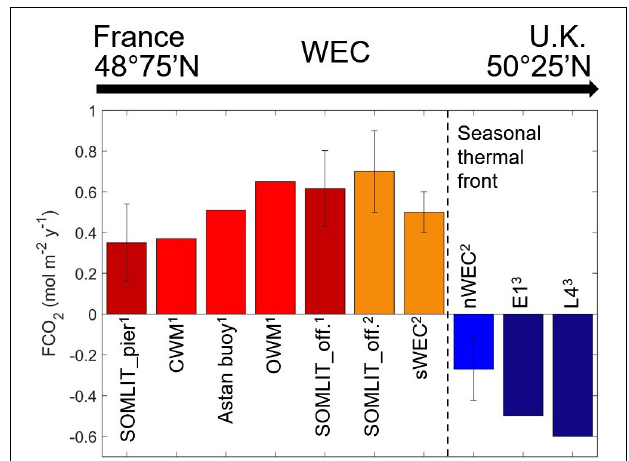
FIGURE 10 | Annual mean FCO 2 (mol C m − 2 y − 1 ) across the WEC at discrete stations SOMLIT-pier and SOMLIT-offshore for the 2015–2019 period (dark red), in the CMW, OMW and at ASTAN based on HF data from 2016 and 2019 (red) from this study 1 ; at SOMLIT-offshore (orange), in the sWEC (orange) and nWEC (blue) for the period 2011–2013 from Marrec (2014) 2 ; and at discrete stations E1 and L4 (dark blue) for the period 2007–2010 from Kitidis et al. (2012) 3